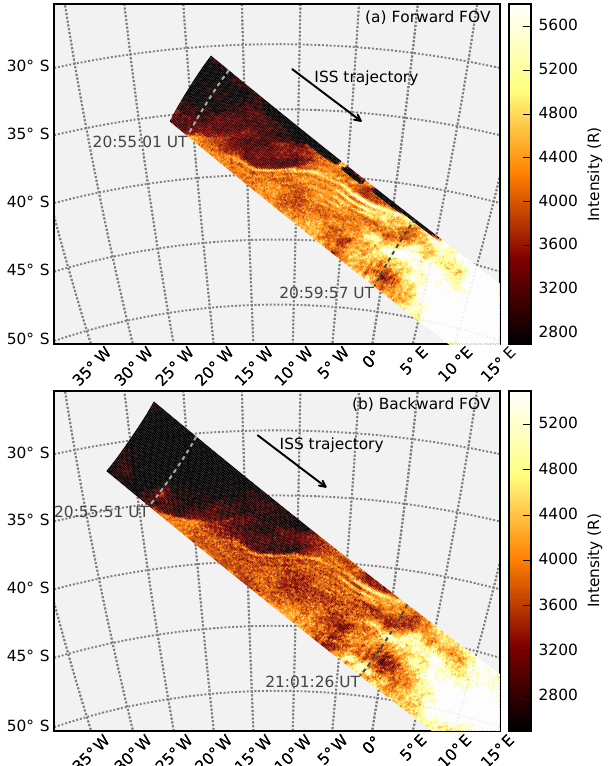
Figure 3. O 2 (762nm) airglow images obtained by VISI with the forward and backward FOV on 7 May 2013. The start and end times of capturing the bore front are indicated with dashed